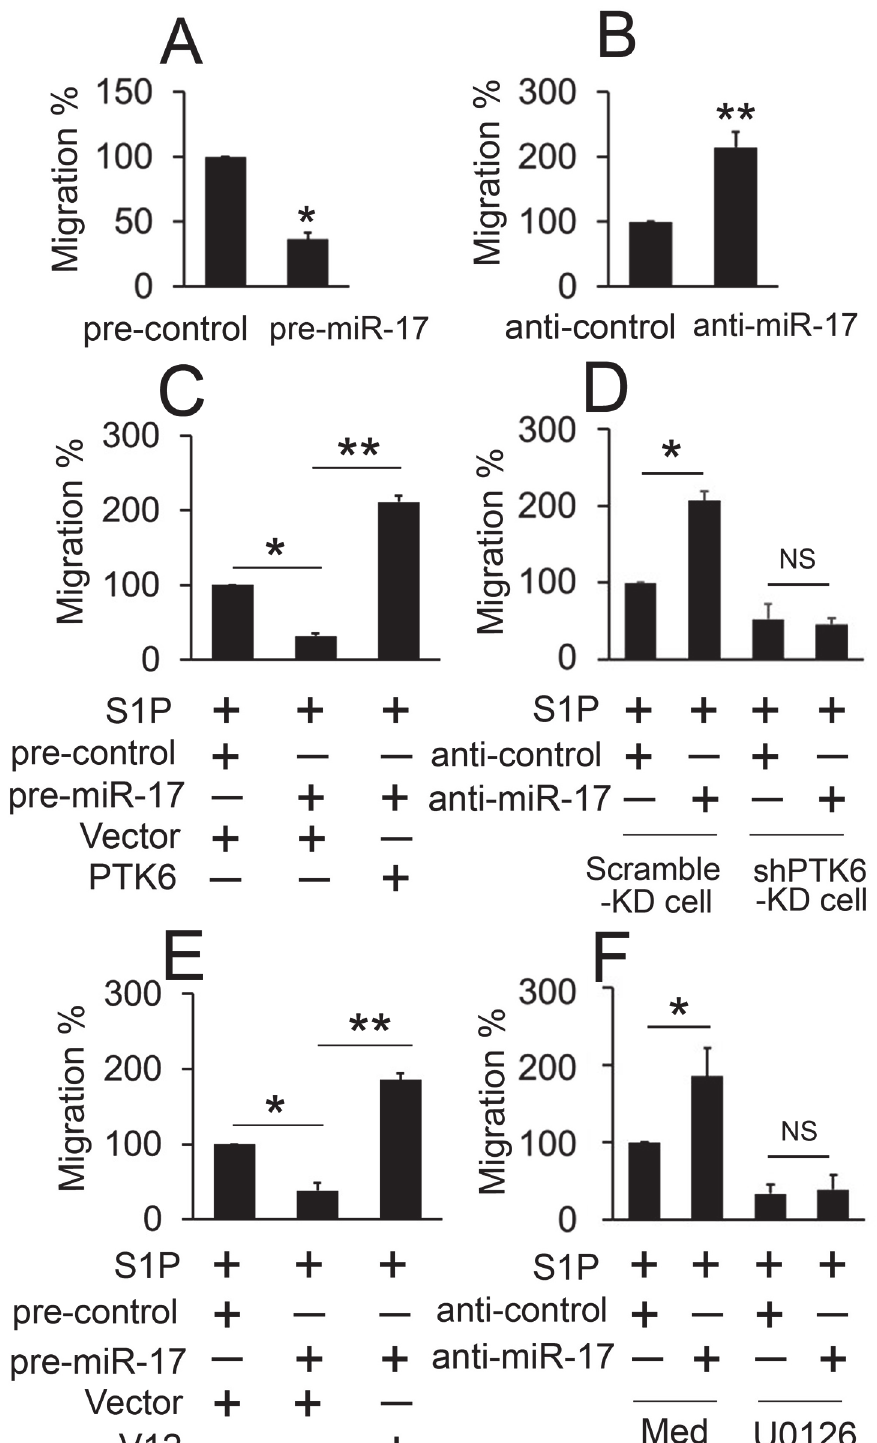
Fig 4. miR-17 inhibits the S1P-induced cell migration through the PTK6-ERK signal pathway. (A) ML-1 cells were transfected with pre-miR-17 or pre-control for 24 hours and treated with S1P (100 nM, 30 min) and allowed to migrate towards serum for 12 hours. (B) Experiments were performed as in A except anti-control and anti-miR-17 were used. (C) ML-1 cells were transfected with the indicated plasmids and miRNAs for